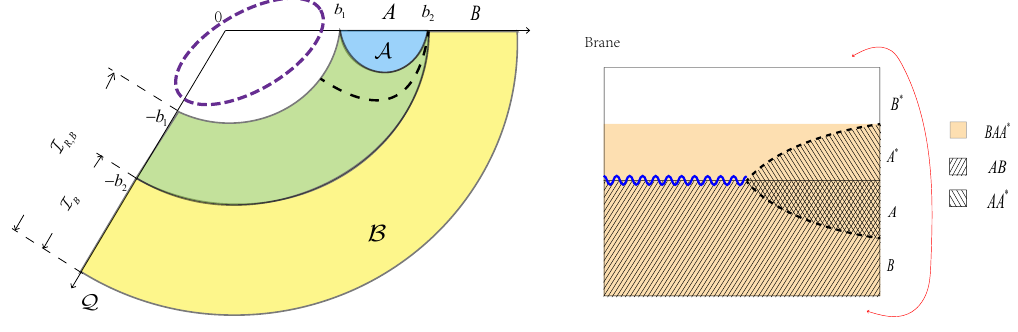
Figure 11 . Phase-A3. In this phase, A and B are adjacent, and A admits no island. recovery ( h = 0 ) for phase-A1 while no perfect Markov recovery ( h > 0 ) for phase-A2 away from the phase transition. In fact, as shown in figure 10, for another Markov recovery map ρ = R ( ρ ) , the entanglement wedge of AB together with that of BB ∗ cannot ABB ∗ B → BB ∗ AB cover all the entanglement wedge of ABB ∗ , which obviously signals an imperfect Markov recovery for